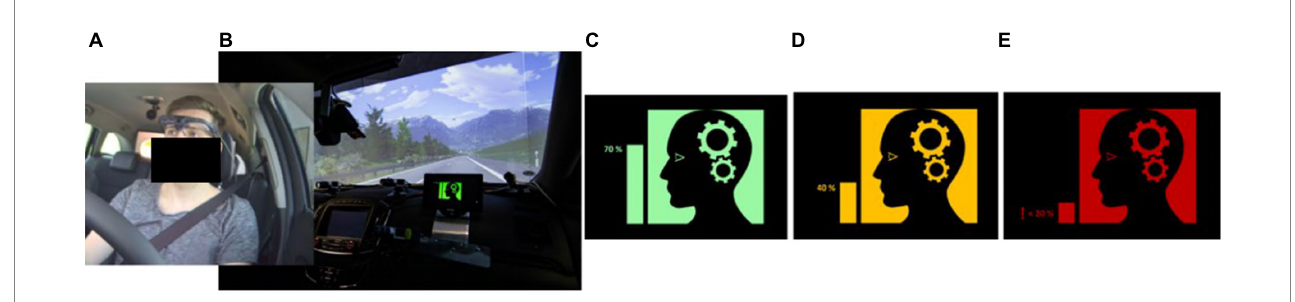
FIGURE 3 Driver attention display. (A) driver with eye-tracking glasses and two EEG electrodes in the temporal area. (B) Passenger display on the dashboard, showing the attention status of the driver. (C–E) Icons used for high (70–100%), medium (40%) and low/critical (<20%) attentiveness of the driver.